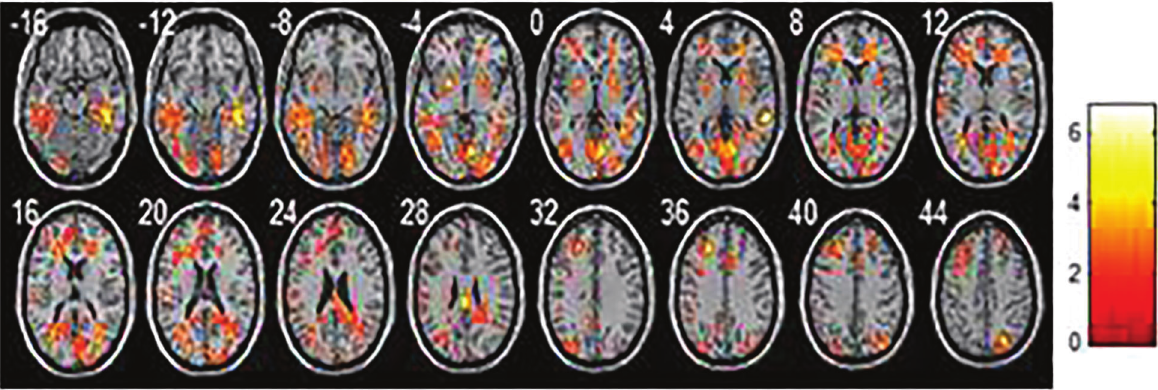
Figure 3. Regions where homogeneity decreased in the amnestic mild cognitive impairment group compared with the normal elderlies. Each image represents a slice, with 4 mm distance from the other. 0 is the 0 position of space coordinates. The color bar indicates energy intensity.